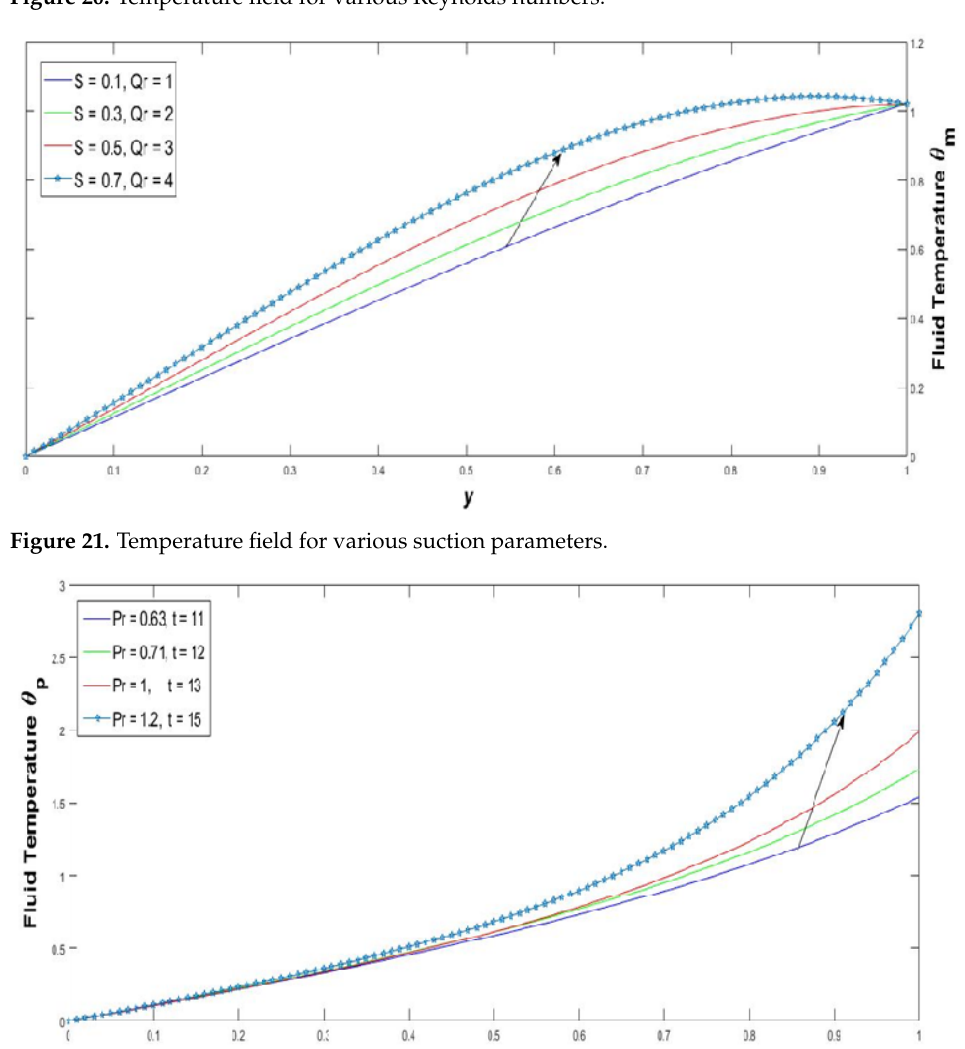
Figure 20. Temperature field for various Reynolds numbers.